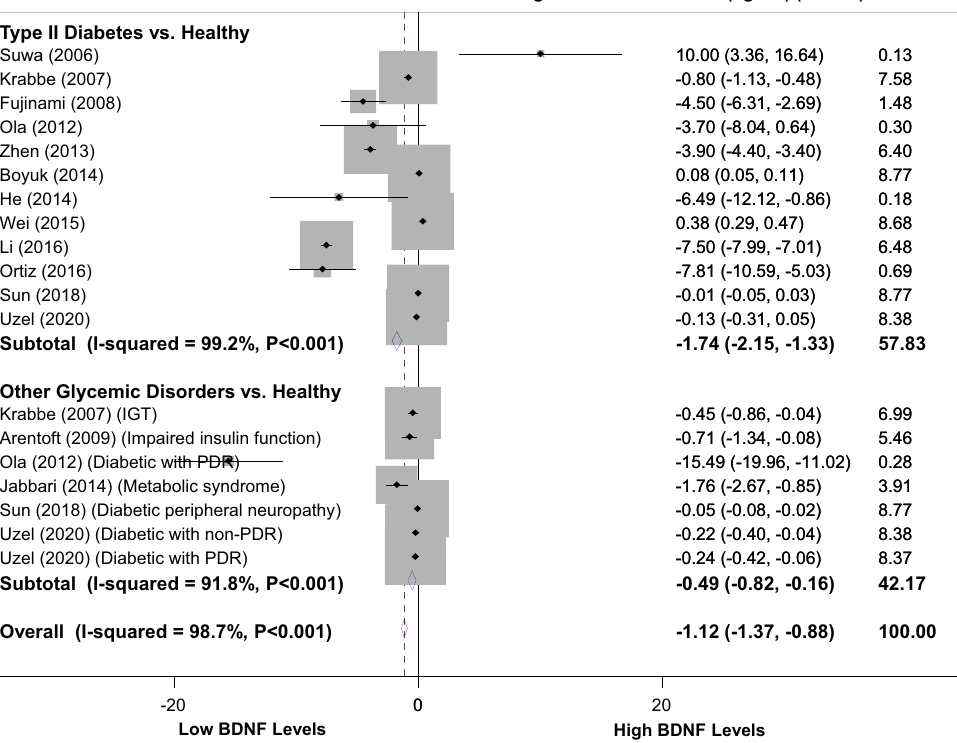
Figure 2. Forest plots depicting the weighted mean difference of serum/plasma BDNF levels of patients with Type 2 Diabetes or other glycemic disorders compared to healthy